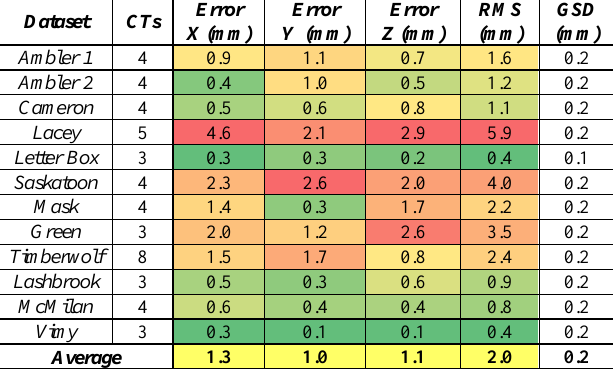
Table 1. Resulting errors for the 12 photogrammetric datasets and their average effective GSD calculated by PS.